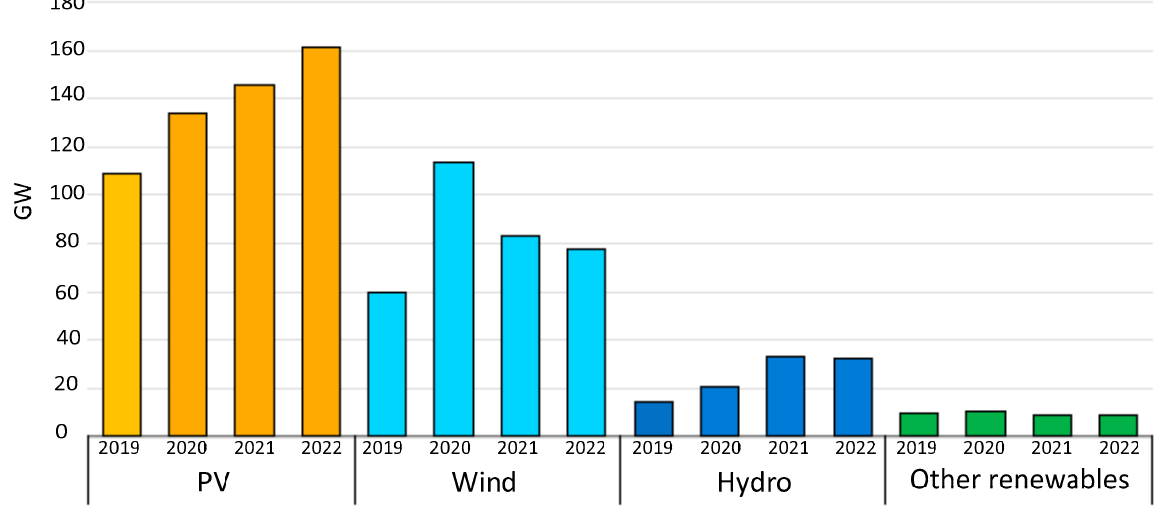
Figure 1. Global increase in renewable generation capacity between 2019 and 2022.